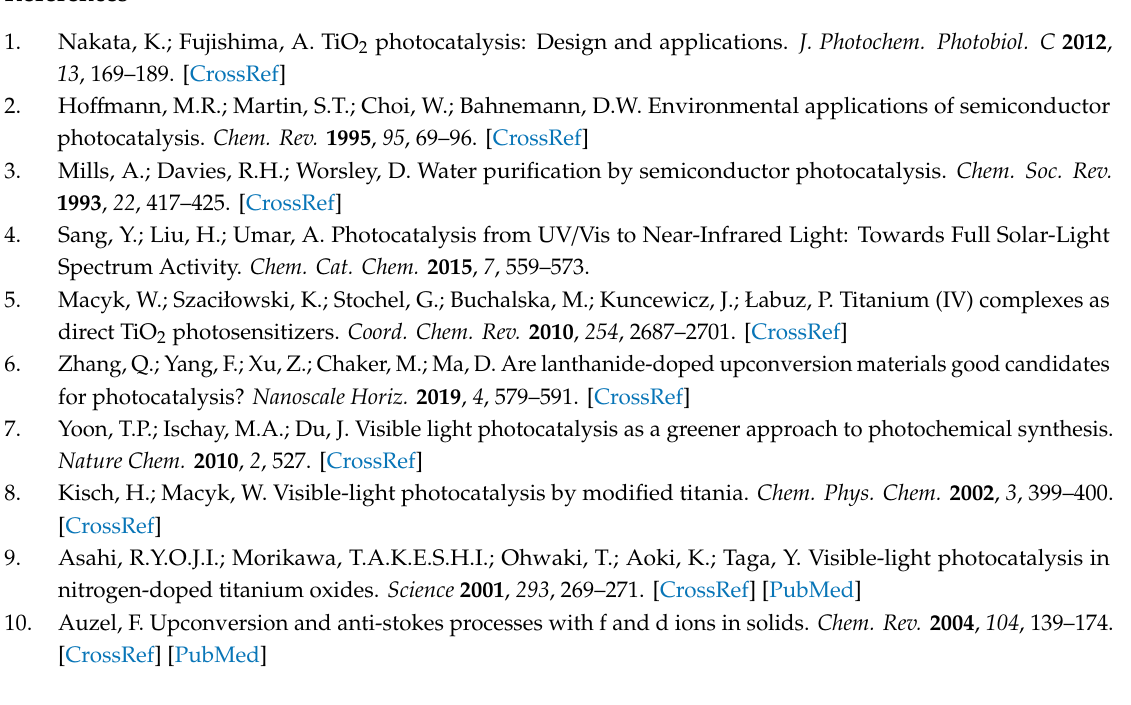
ions ratio is significantly increasing with the penetration depth, what indicates higher content of Y 3 + ions at the surface of studied